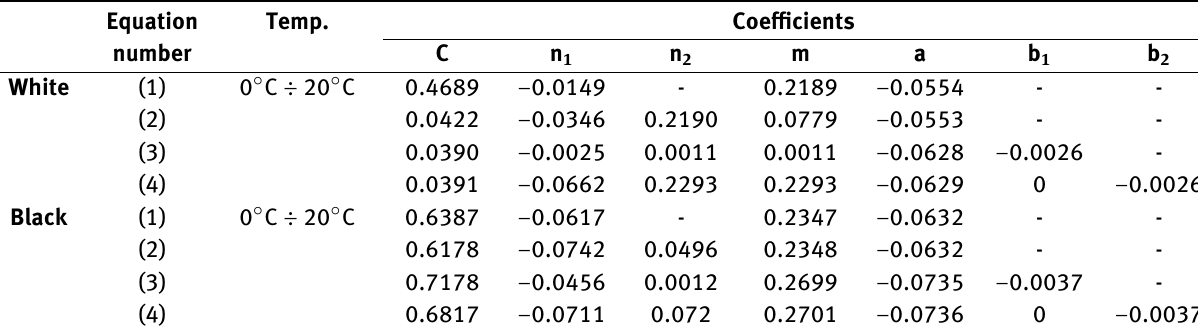
Table 2: Comparison of coeflcients of functions determined by equations (3) ÷ (6). Equation Temp. White